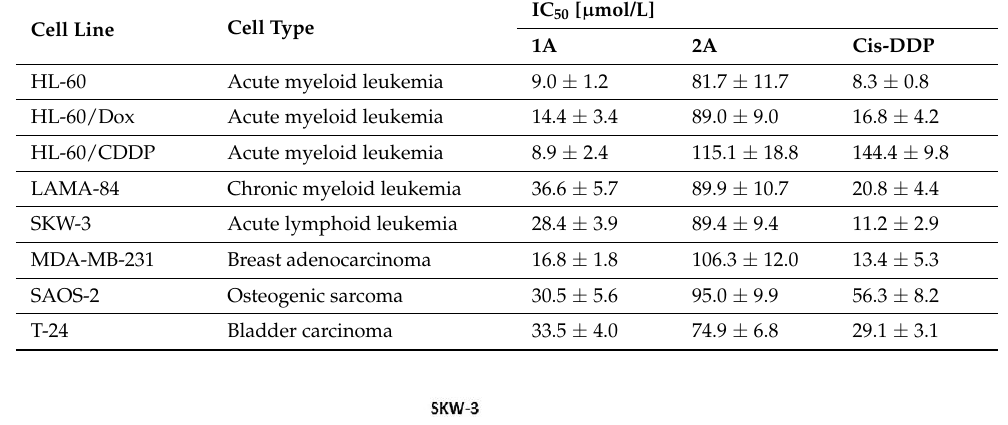
Table 2. Antiproliferative activity of taciplatin ( 1A ), ditaciplatin ( 2A ), and the reference drug cisplatin (Cis-DDP) after 72 h continuous incubation (MTT-dye reduction assay).